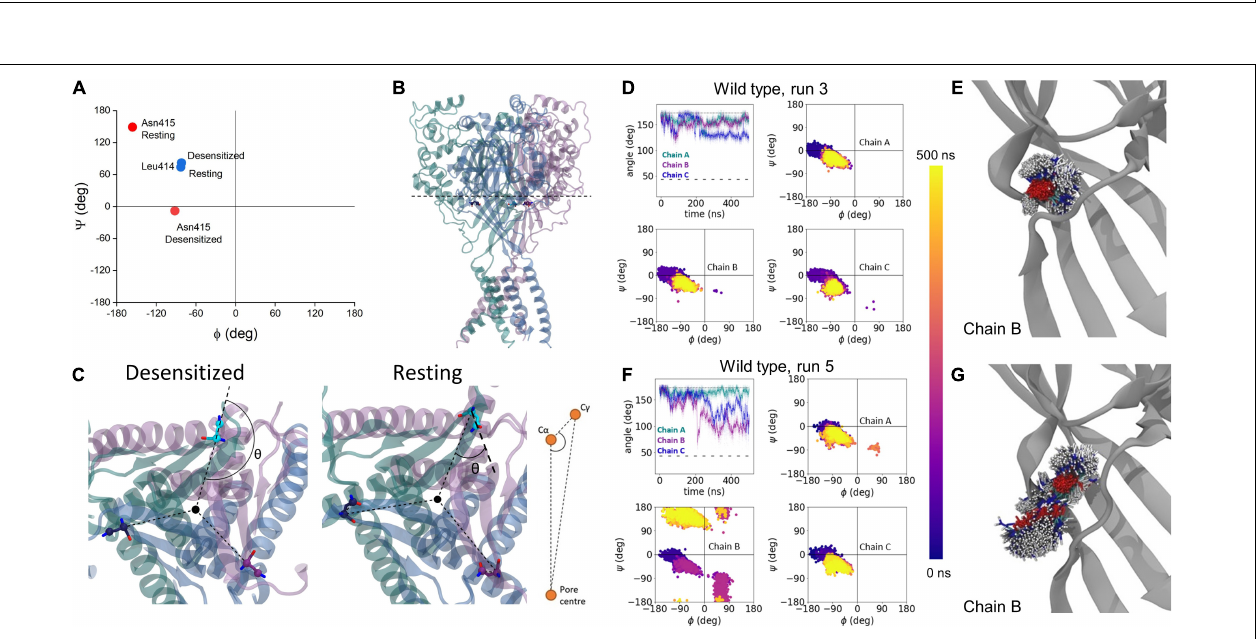
Frontiers in Cellular Neuroscience |